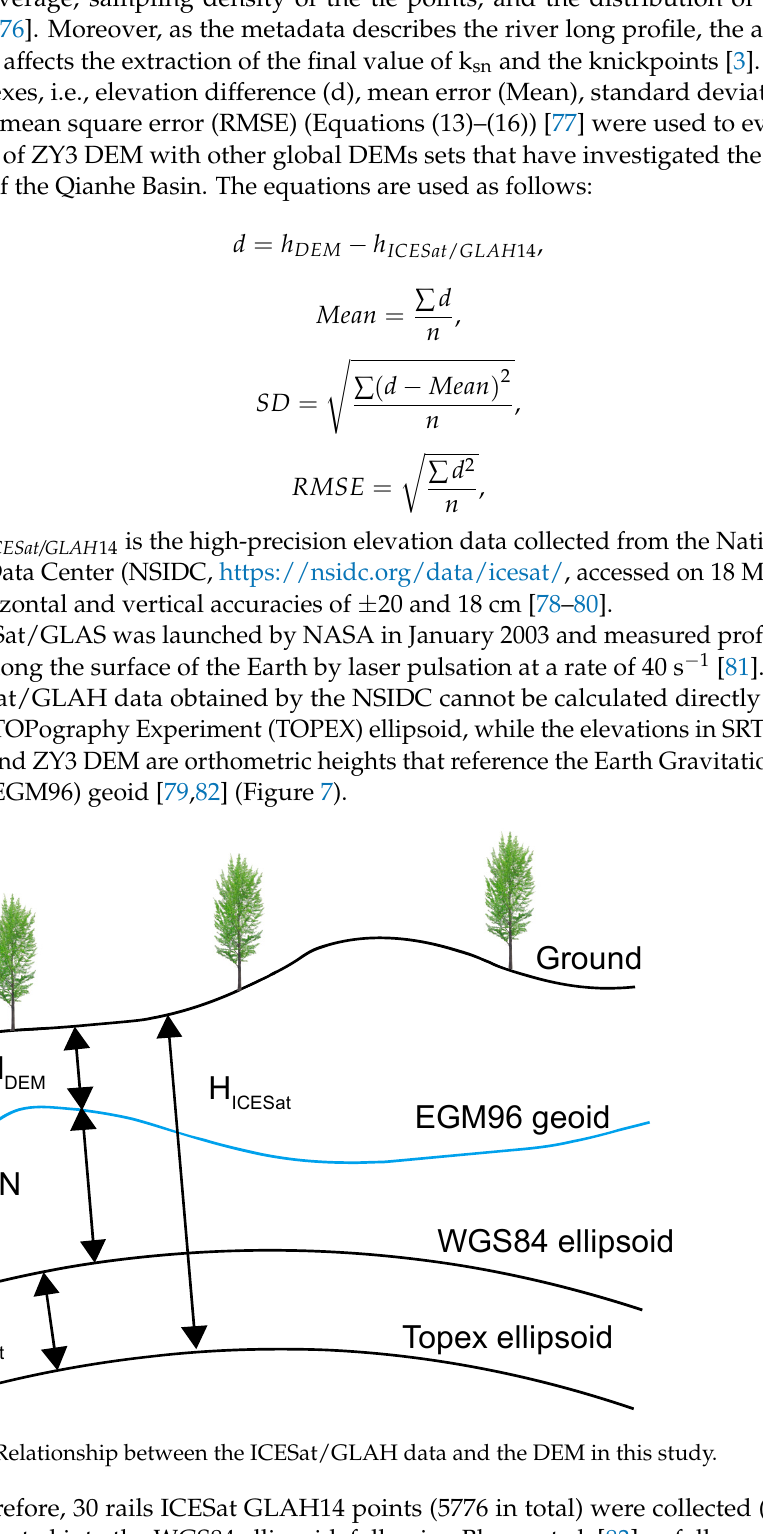
Figure 6. ( a ) The DEM was generated from ZY3 satellite stereo images in the Qianhe Basin. The ICESat/GLAH14 data is the elevation data from the National Snow and Ice Data Center (NSIDC, https://nsidc.org/data/icesat/, accessed on 18 March 2021). The 1:50,000 DEM data is collected from the fieldwork [74]. See Figure 1 for active faults names; ( b ), ( c ), and ( d ) are the hillshade maps of